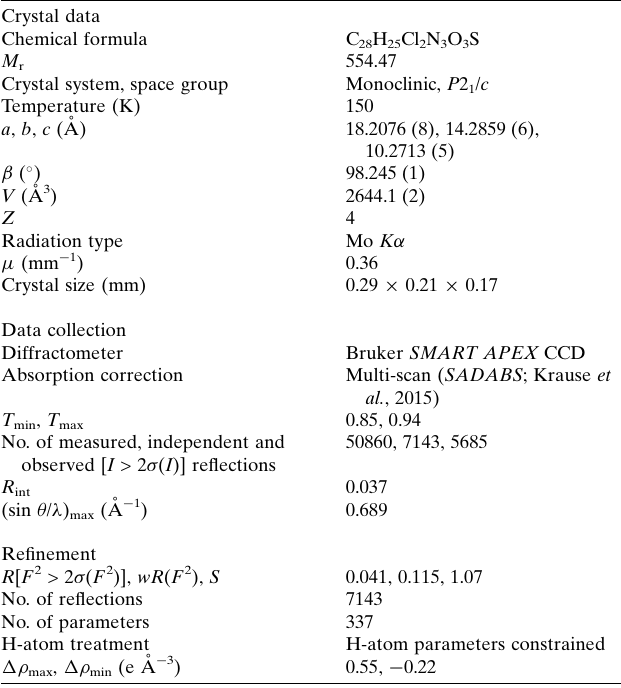
Table 4 Experimental